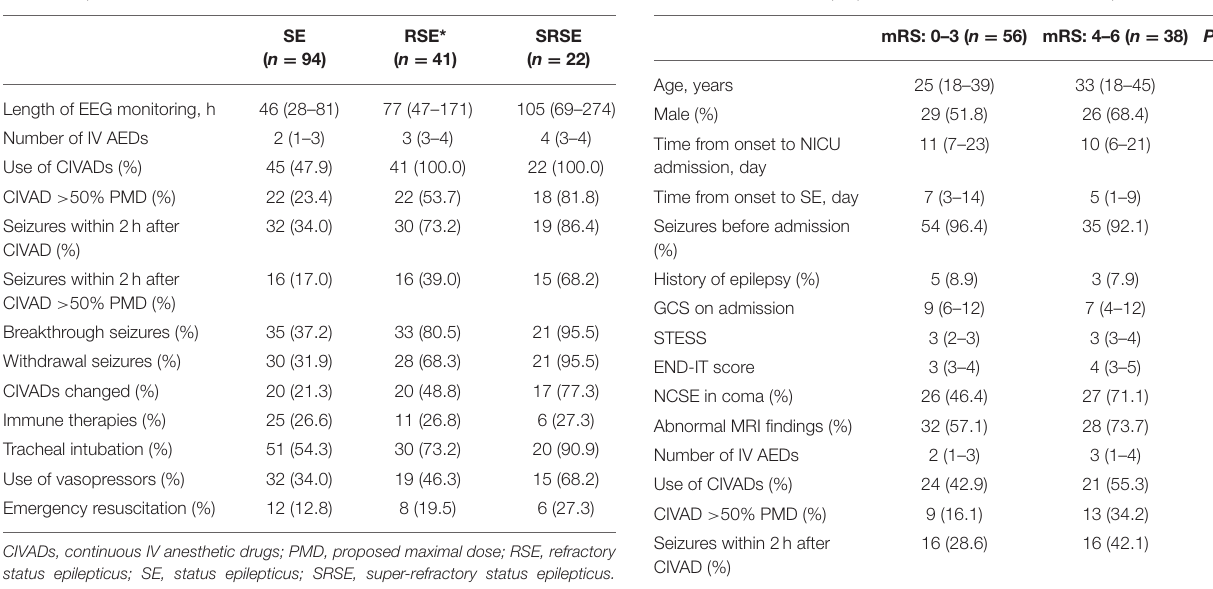
TABLE 4 | Clinical characteristics of patients with favorable and unfavorable outcomes after status epilepticus associated with acute